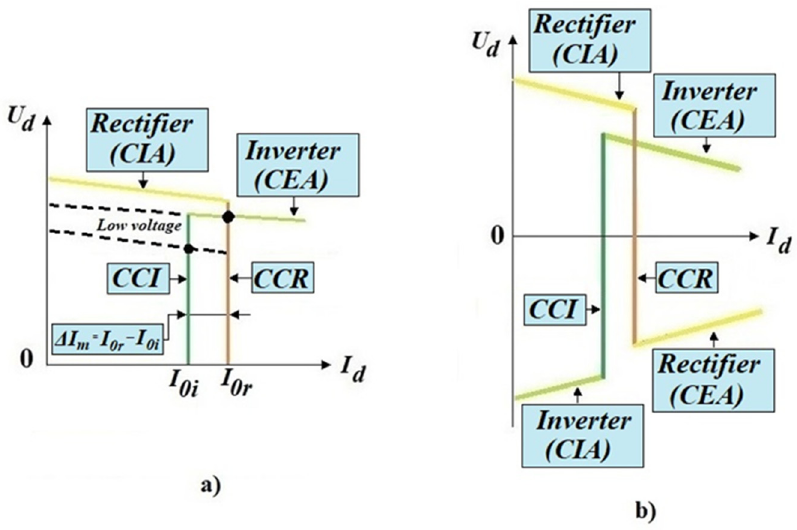
Figure 12. LCC-HVDC-U-I steady-state characteristics ( a ) steady-state operation; ( b ) combined op-